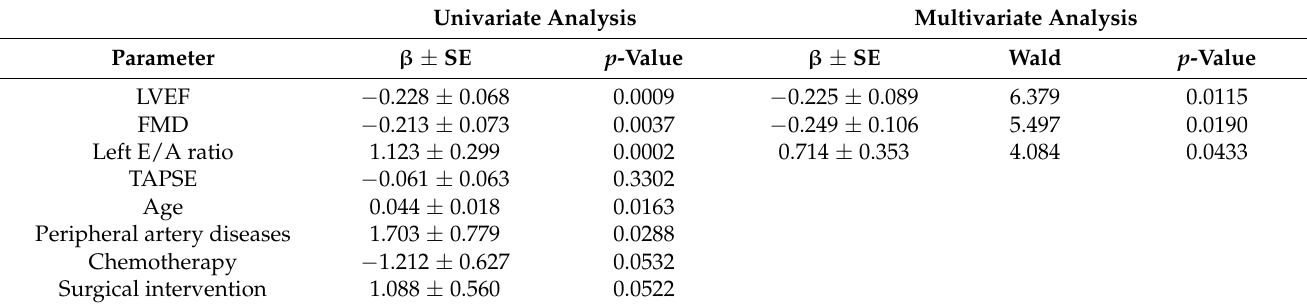
Table 4. Univariate and multivariate Cox regression analysis with independent all-cause mortality predictors. Univariate Analysis Multivariate